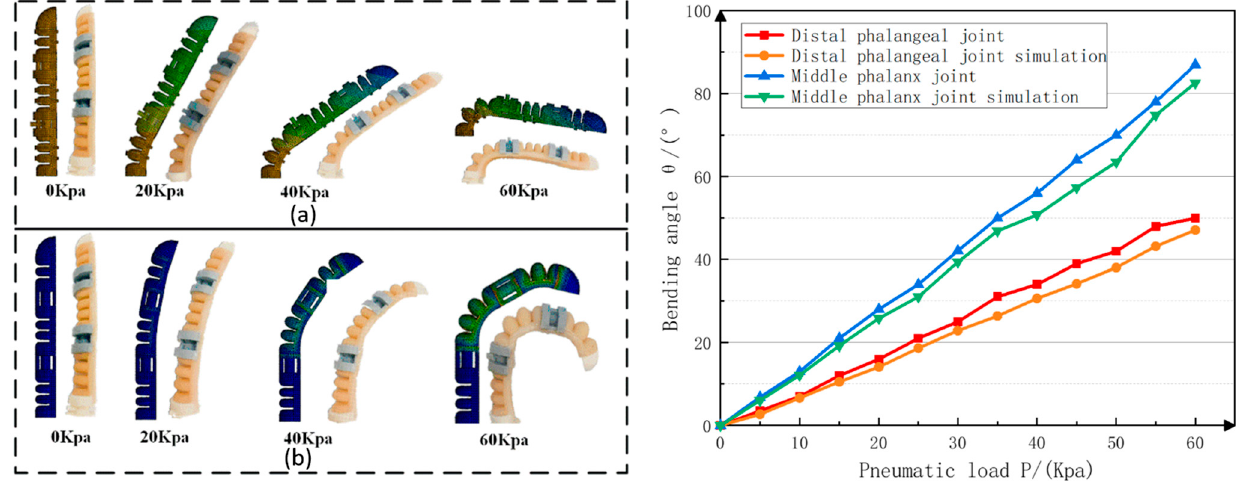
Figure 15. Middle finger bending experiment and simulation comparison of the bionic finger: ( a ) Bending near the phalanx; ( b ) The middle phalanx and the distal phalanx bend at the same time.